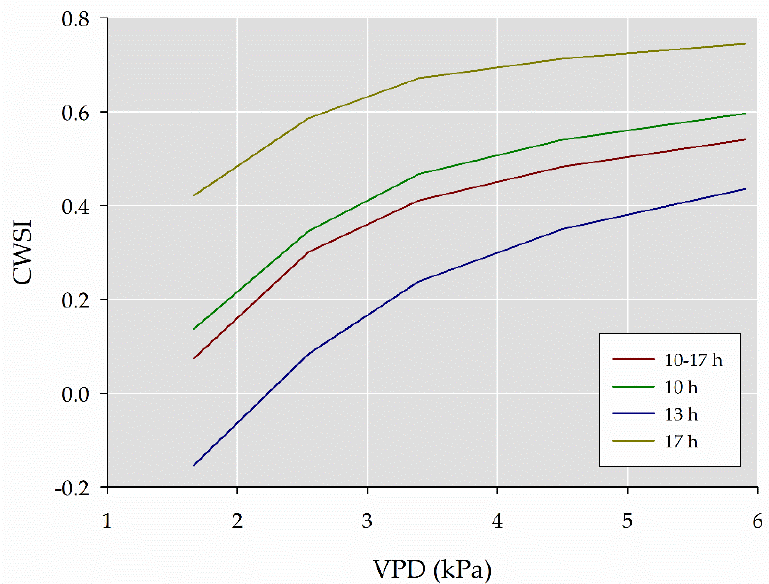
Figure 5. Sensitivity analysis of crop water stress index (CWSI) to four pairs of a pot /b pot values: (1) values derived for the period 10–17 h UTC, (2) values derived for the 10 h UTC time period, (3) values derived for the 13 h UTC time period, (4) values derived for the 17 h UTC time period. Equa-